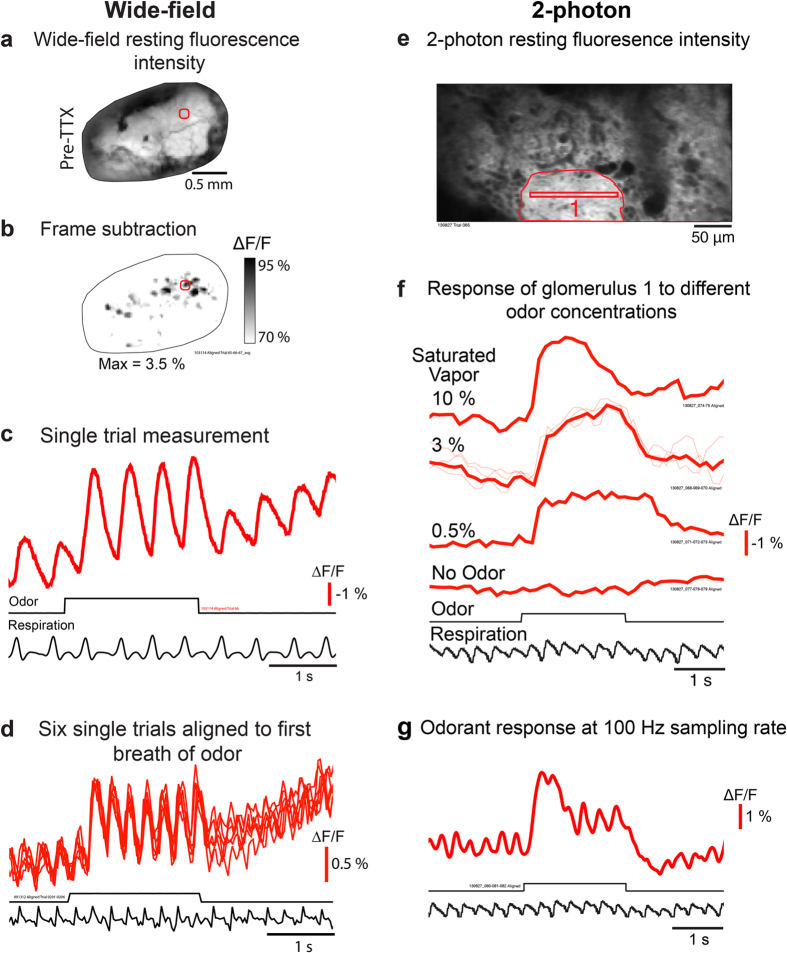
Odor-evoked ArcLight signals in single trials using wide-field and 2-photon microscopy.(a-d) Wide-field epifluorescence microscopy. (a) Wide-field resting fluorescence intensity. (b) Glomerular patterns of activation after odor presentation. (c) Odor-evoked optical measurement from the region of interest marked with a red circle in a-b. The frame subtraction map in b is from an average of 3 respiration aligned trials with no spatial filtering. The optical measurement in c is from an unfiltered single trial (the respiration trace is filtered at 4 Hz). (d) Six unfiltered single trials aligned to the first sniff of odorant. The respiration trace is from one of the single trials. (e-g) 2-photon scanning microscopy. (e) 2-photon resting fluorescence intensity from the glomerular layer in the rostral bulb. (f) Optical measurements from glomerulus 1 in panel e in response to ethyl tiglate at 3 odor concentrations and an air alone presentation. The optical traces in f are averages of 2-3 respiration aligned trials (thick lines); single trials are shown as thin lines for the 3% saturated vapor condition. Measurements were recorded at a sampling frequency of 8 Hz, and the traces were Gaussian low-pass filtered at 2 Hz. (g) Increasing the 2-photon sampling rate improved the signal-to-noise ratio and revealed respiration coupled ArcLight signals. The optical signal in panel g is from the smaller imaging area in panel e (512 × 16 pixels, thin red box in glomerulus 1) and is from an average of 3 respiration aligned trials. The optical traces in g were recorded at a sampling frequency of 100 Hz, and were Gaussian low-pass filtered at 4 Hz. The respiration traces in panels f and g are from single trials. The data in a-c, d, and e-g are from three different preparations.